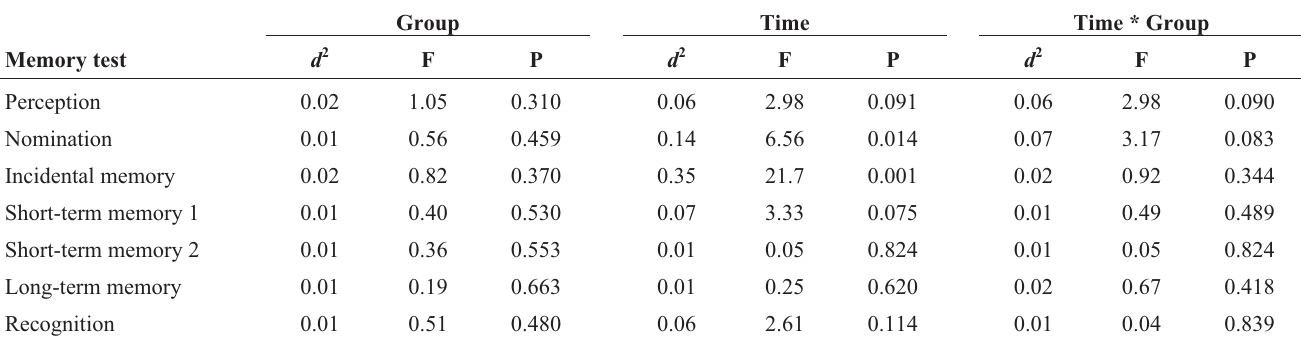
Table 2 - Values of the effect size ( d 2 ) , F and P value for memory tests evaluated between the groups, time of intervention and interaction. Group Time Time *